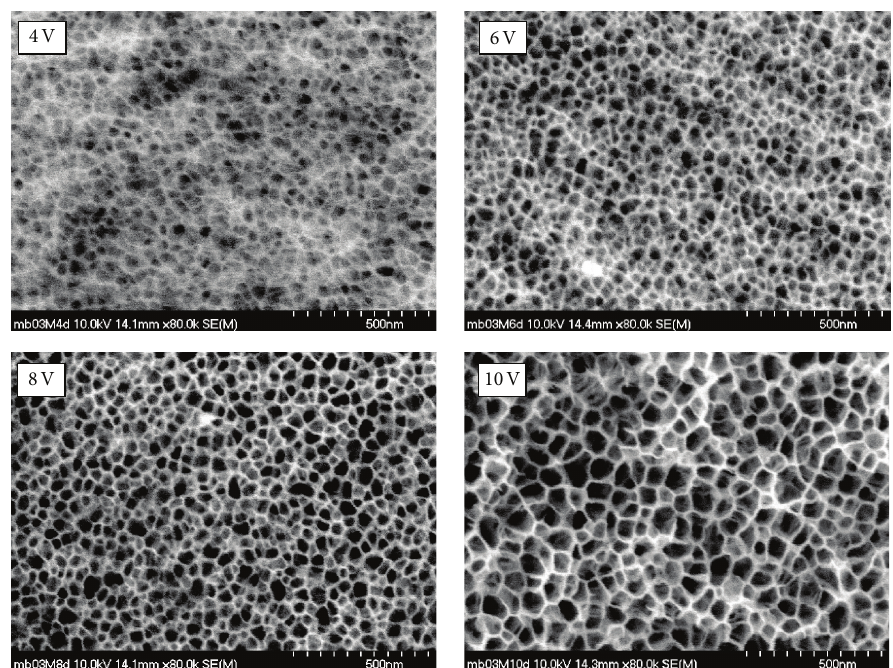
Figure 5: FE-SEM images of nanoporous tin oxide layers formed by one-step anodization in 0.3 M oxalic acid under different anodizing conditions. The A-type electrochemical cell was